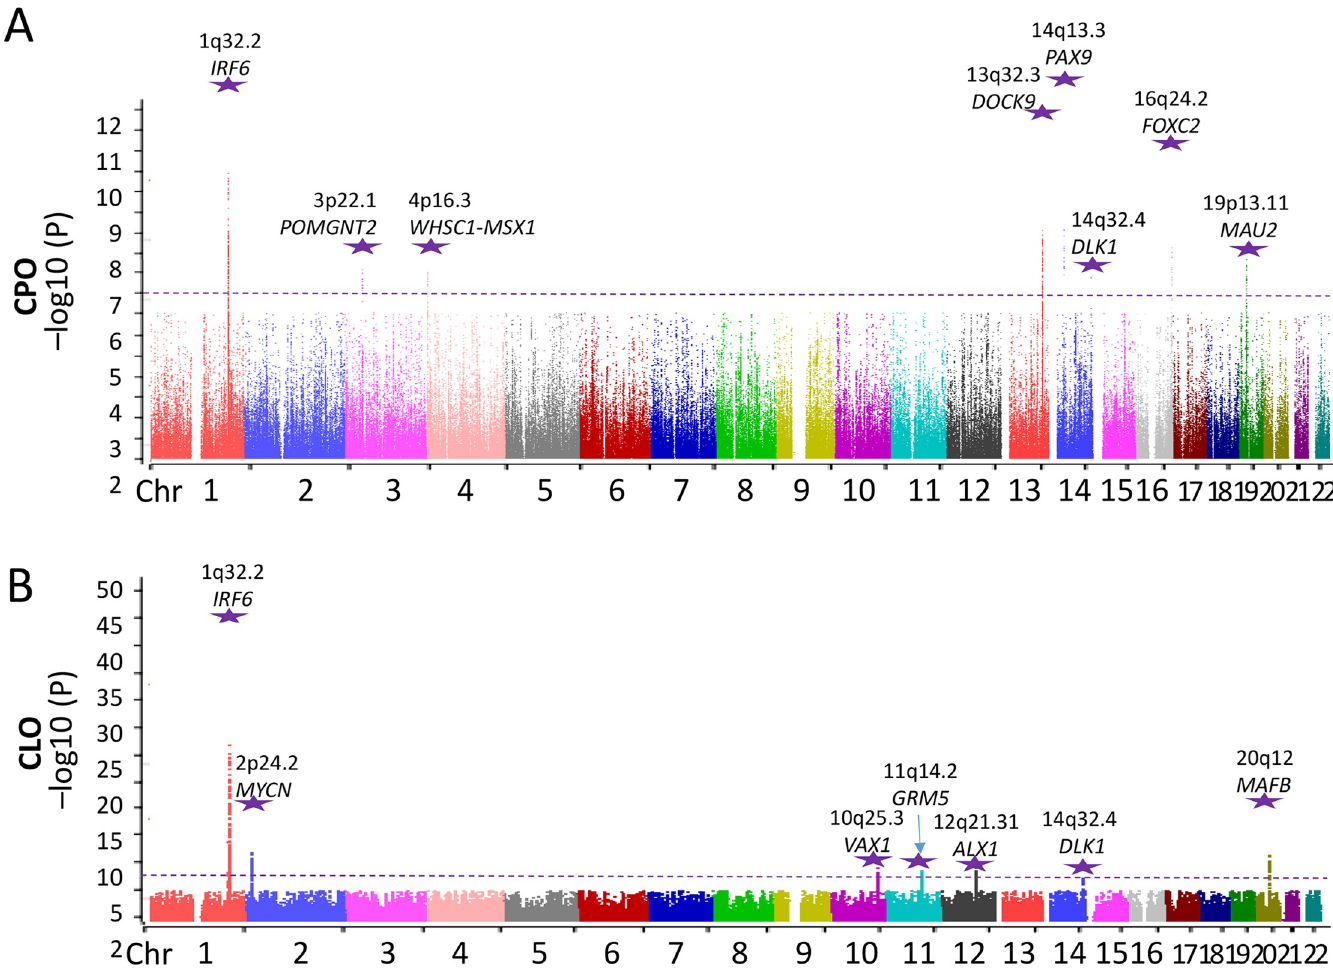
Fig 1. Manhattan plots for genes/loci identified by typical GWAS. Manhattan plot showing the − log 10 P values of the association analysis of SNPs passing the Hardy– Weinberg test with a P value > 1.0 × 10 − 6 . The plot includes GWAS data for the discovery cohort, comprising 930 CPO patients (A) , 945 CLO patients (B) and 5048 healthy control individuals of Southern Han Chinese ethnicity, plotted against the respective positions of SNPs on the autosomes. The purple dashed line shows the exome-wide significance threshold for this study ( P = 9 × 10 − 7 ). Purple stars indicate the results of a final meta-analysis incorporating the GWAS discovery cohort and two replication cohorts, comprising a total of 2071 CPO cases, 2218 CLO cases and 10165 control